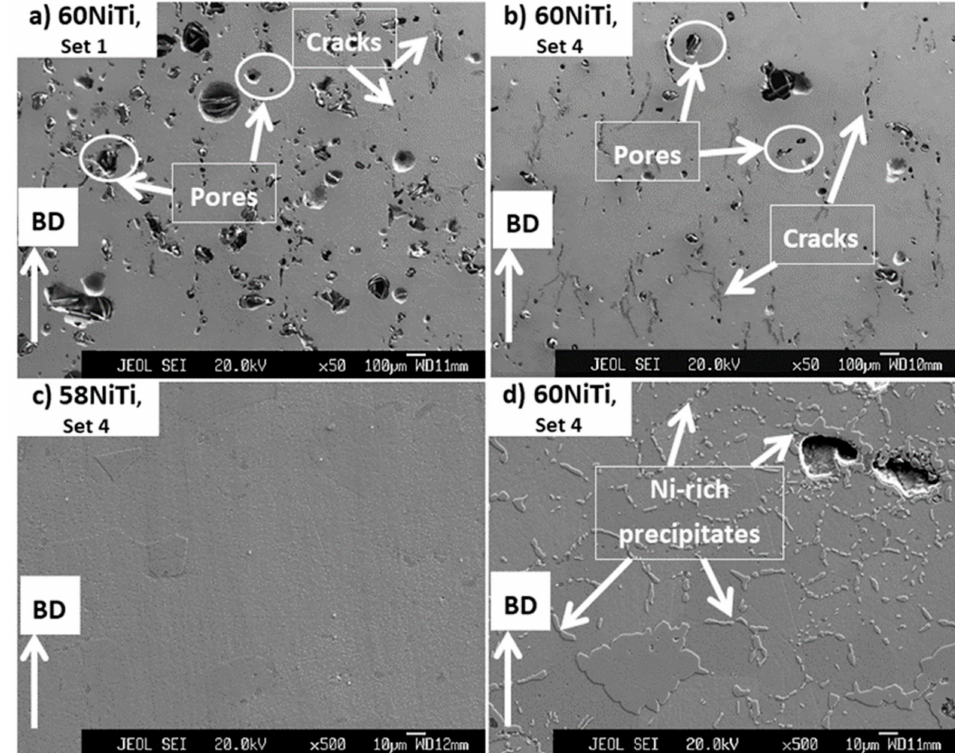
Figure 13. Images obtained from the cross-section of hardened secondary HIP-treated ( a , b , d ) 60NiTi and ( c ) 58NiTi samples processed from parts printed by ( a ) set 1 and ( b – d ) set 4 having energy inputs of 27.70 and 39.68 J/mm 3 , respectively. The secondary HIP treatments for 60NiTi parts were conducted at 1165 ◦ C and for 58NiTi at 1170 ◦